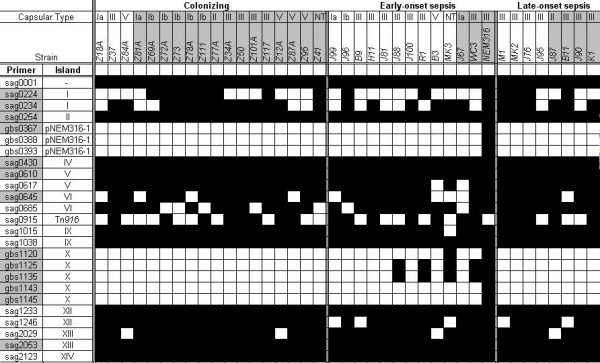
The presence of putative pathogenicity islands as defined by PCR.  Results of PCR (figure 3) and CGH (figure 4) analyses. The genes and GBS strains shaded grey in table 2 are those included in CGH experiments, table 3. Sag0001 encodes dnaA, a positive control for PCR. The NEM316 strain is a positive control. The pNEM316-1 plasmid is located three times in the NEM316 genome, and in figure 1 is represented as 'islands III, VII and VIII'. The strains are divided into three groups: colonizing strains from healthy pregnant women, and strains causing early- and late-onset sepsis in babies; and are sub-divided into those strains for which we have PCR results, and those for which we have PCR and CGH data.